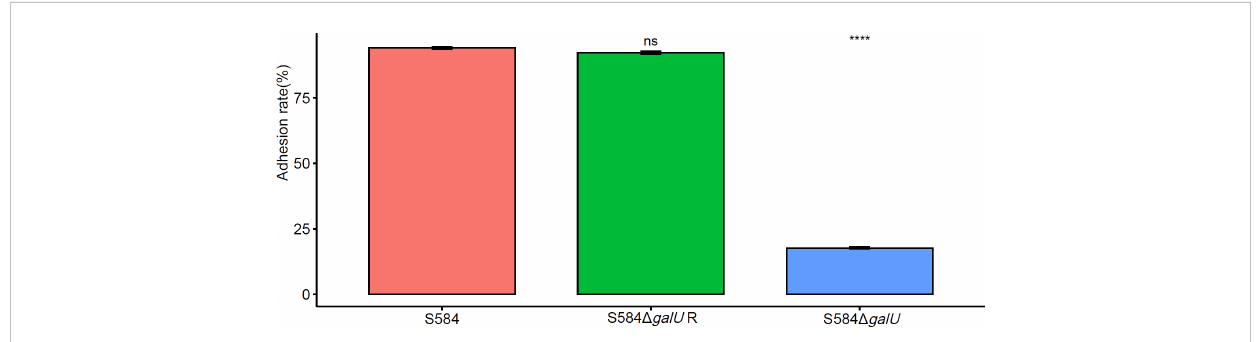
FIGURE 8 Adhesion ability of the three bacterial strains to DF-1 cells. Different colors represent different strains (red = S584, green = S584 D galU R, and blue = S584 D galU ). The vertical coordinate of the graph shows the adhesion rate for each strain to DF-1 cells. Ns means no signi fi cant difference. **** means extremely signi fi cant difference.